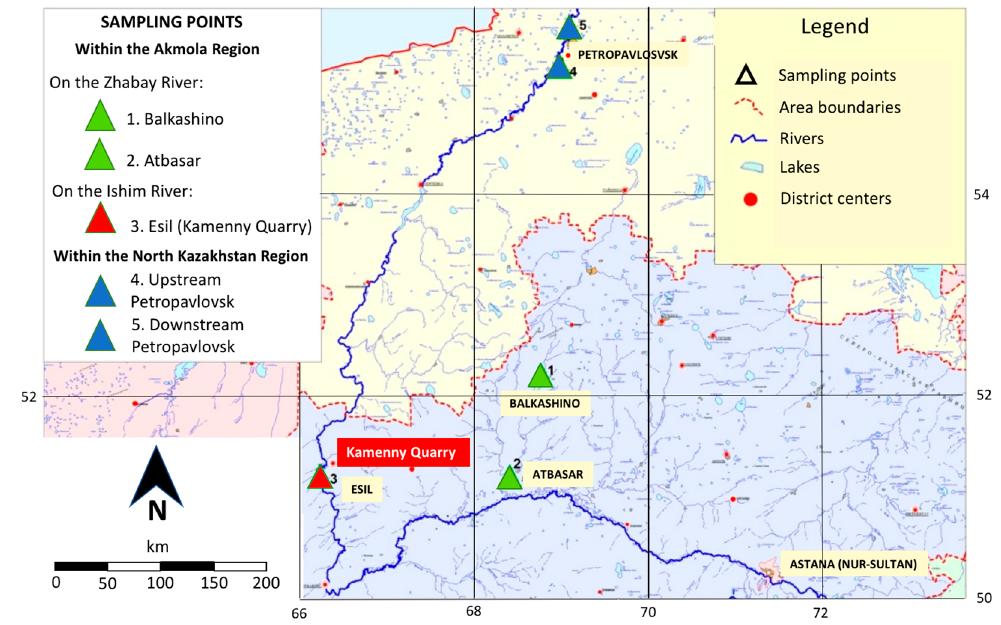
Figure 2. Location of the Kamenny Quarry sampling station inside the Ishim River basin within the Akmola Region.